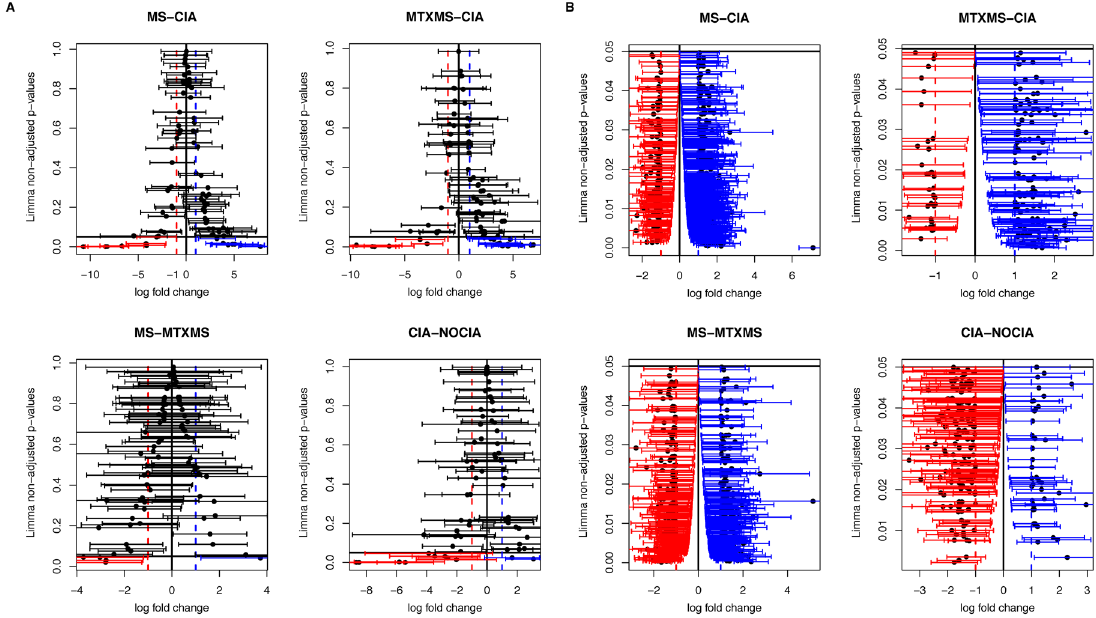
Figure A1. Log fold change confidence interval calculated for ( A ) all gut microbiome genera and ( B ) differential genes ( p < 0.05 and FC ≥ 2) for a better visualization. Increased (log-FC ≥ 1) and decreased (log-FC ≤ − 1) features were labeled in blue and red, respectively.